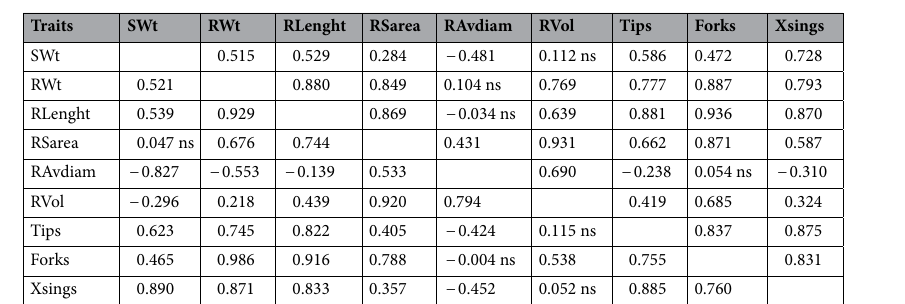
Figure 2. Ranking of root traits based on machine learning and multi-environment trait analysis methods. ( a ) and ( b ) are rankings of the variable importance of eight root traits (vertical axis) in a model for predicting shoot weight under high N-management, HN ( a ) and low N-management, LN (b) using random forest machine learning algorithm. Each point in ( a ) and ( b ) is a cumulative reduction in mean square error (MSE) of regression models each time the corresponding predictor root trait variable is used as a node split in a decision tree. The larger the cumulative reduction in the MSE, the greater the important ace and the higher a root trait ranks across all models tested. The traits have been ranked in ascending order with the least important at the bottom and the most important at the top on the vertical axis. ( c ) and ( d ) show the genetic correlation coefficients ( r g ), and ( e ) and ( f ) the phenotypic correlation coefficient ( r p ) between each variable and shoot weight. Correlation size and significance are shown on each bar. A negative ( −) before a number indicates it is a negative correlation, *significant at P = 0.05 and **significant at p < 0.01.